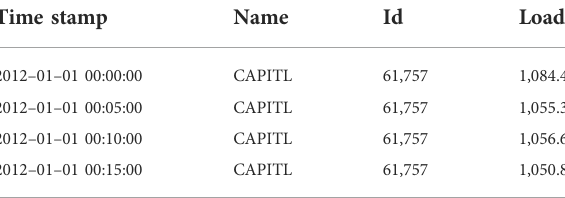
TABLE 2 Part of the EEC data after data cleaning.